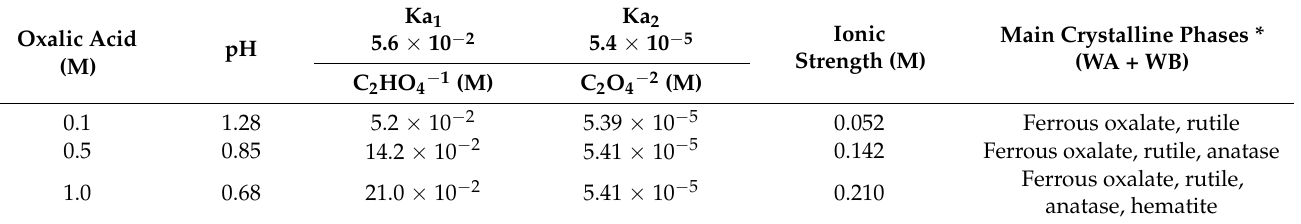
Table 2. Chemical properties of oxalic acid solutions of different molarity and main crystalline phases identified in the as-synthesized product streams obtained with oxalic acid solutions at 155 ◦ C and 50